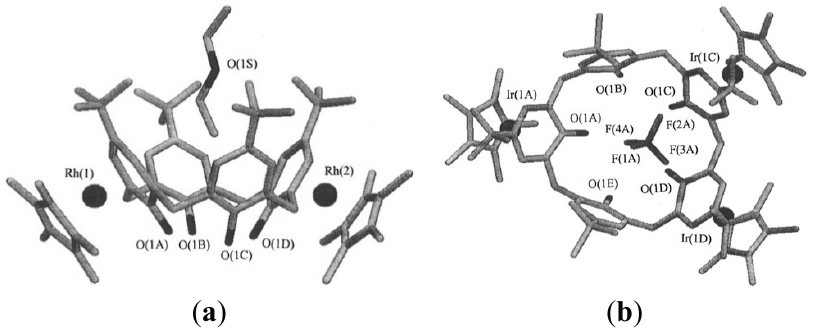
Figure 14. ( a ) Crystal structure of a dirhodium p - tert -butylcalix[4]arene complex, with diethylether in the cavity; ( b ) Crystal structure of a triiridinum p-tert- butylcalix[5]arene complex with an encapsulated tetrafluoroborate anion inside [58]. Reprinted with permission from Staffilani, M.; Hancock, K.S.B.; Steed, J.W.; Holman, K.T.; Atwood, J.L.; Juneja, R.K.; Burkhalter, R.S. Anion binding within the cavity of π -metalated